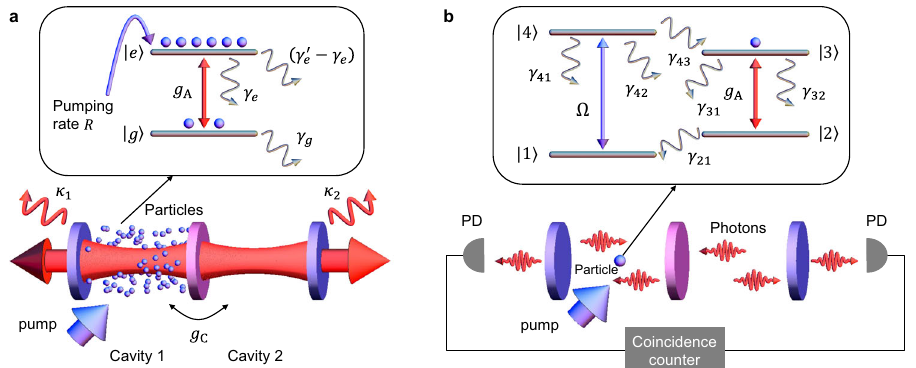
Fig. 1 Two coupled optical cavities in the lasing regime. a Conventional laser system. Two Fabry – Pérot cavities 1 and 2 share the same mirror (purple disc), resulting in an intercavity coupling strength g C . The photon loss rates of two cavities are κ 1 and κ 2 , respectively. The active particles are located inside cavity 1, which is coupled to the laser transition of the particles with a strength g A . The laser transition is formed by a pair of upper e ij and lower g ij levels of particle. The particles are pumped onto e ij at a rate R . The e ij -populated particles decay at a rate γ 0 , where the decay rate corresponding to the e ij (cid:2) g ij e ¼ ð γ 0 þ γ Þ = 2. In this study, we set . The decay rate of the g ij -populated particles is γ . The relaxation constant of the particle polarization is γ branch is γ e g eg g e κ ¼ 2 κ γ ¼ 10 κ γ 0 ¼ γ ¼ g ¼ 20 κ ð κ ; γ Þ is accessed. b One-particle laser. An active particle is 2 1 , 1 , and A 1 and the strong-coupling regime with g A > 1 e g eg e placed inside cavity 1. The particle is characterized by four states, where a pump light drives the 1 ij (cid:2) 4 ij transition with a strength Ω and the coupling strength between the lasing 2 ij (cid:2) 3 ij transition and cavity 1 is g A . The population inversion is achieved via the spontaneous emission from 4 ij to 3 ij . The decay rate of the particle from i ij to j ij with i ; j ¼ 1 ; 2 ; 3 ; 4 and i > j is de fi ned as γ . The cross-coincidence of the photon emissions from the two cavities is ij ¼ γ ¼ γ ¼ γ ¼ 10 κ γ ¼ κ measured by two photodetectors (PDs) that are, respectively, placed in front of two output cavity mirrors. We set γ 1 , 1 , 41 43 31 32 42 γ ¼ 20 κ κ ¼ 2 κ Ω ¼ g ¼ 40 κ = Γ 2 (cid:3) 1 and 4 g 2 = κ Γ (cid:3) 1 with Γ ¼ γ þ γ þ γ 2 1 , 2 1 , and A 1 and the strong-coupling limit, that is, 4 g 1 32 32 A A 32 21 32 31 21